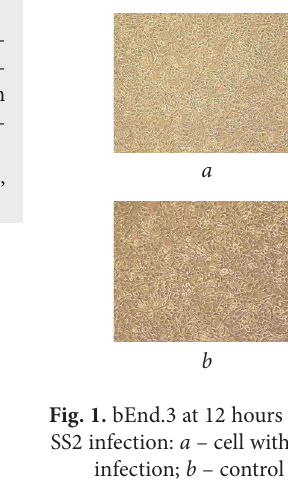
Extracted total RNA were detected by Nanodrop instrument and the concentration and purity were obtained ( Tables 2, 3